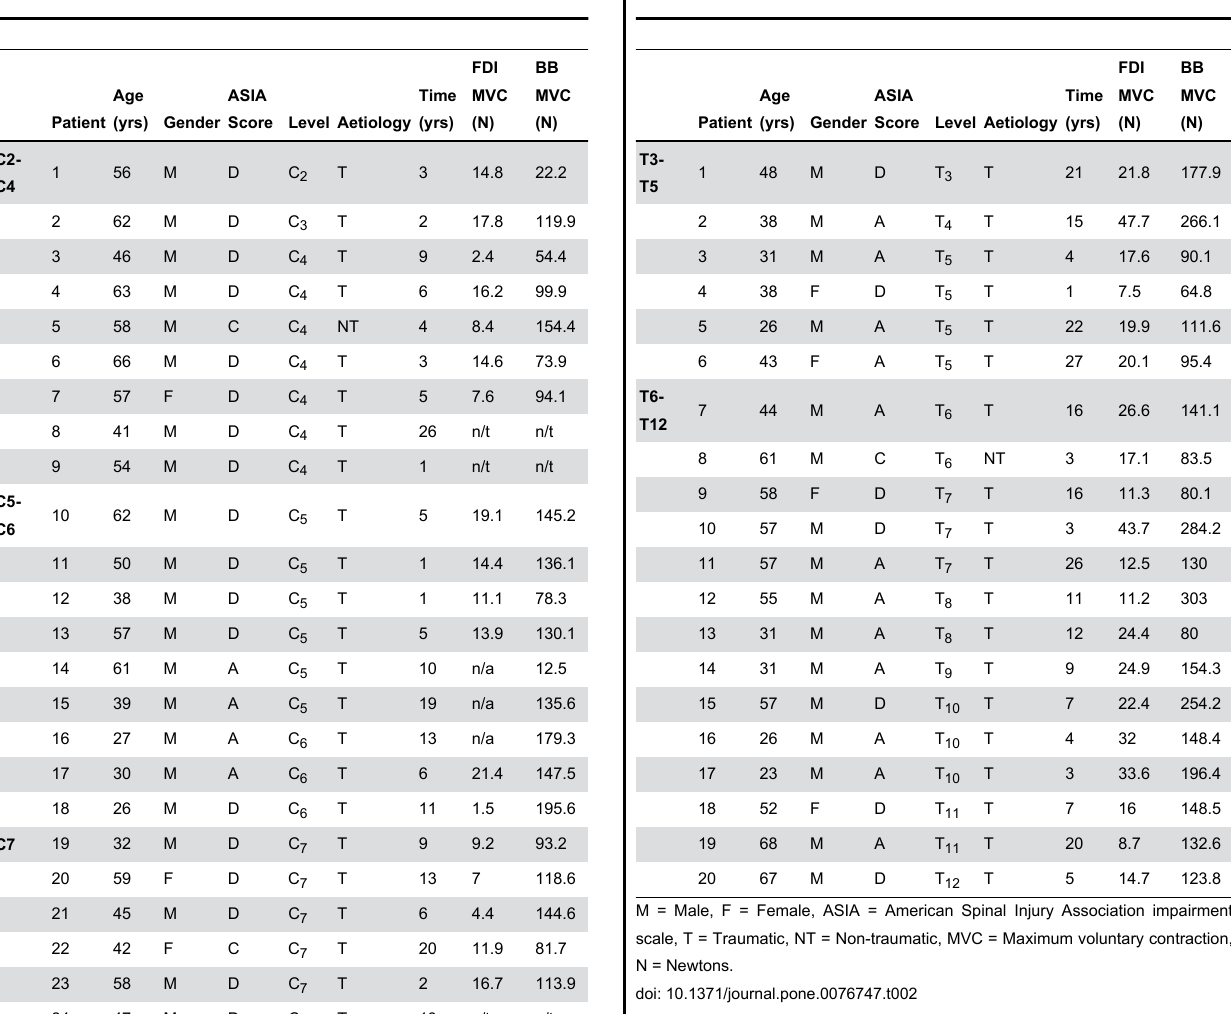
Table 1. Cervical spinal cord injury participants. Table 2. Thoracic spinal cord injury